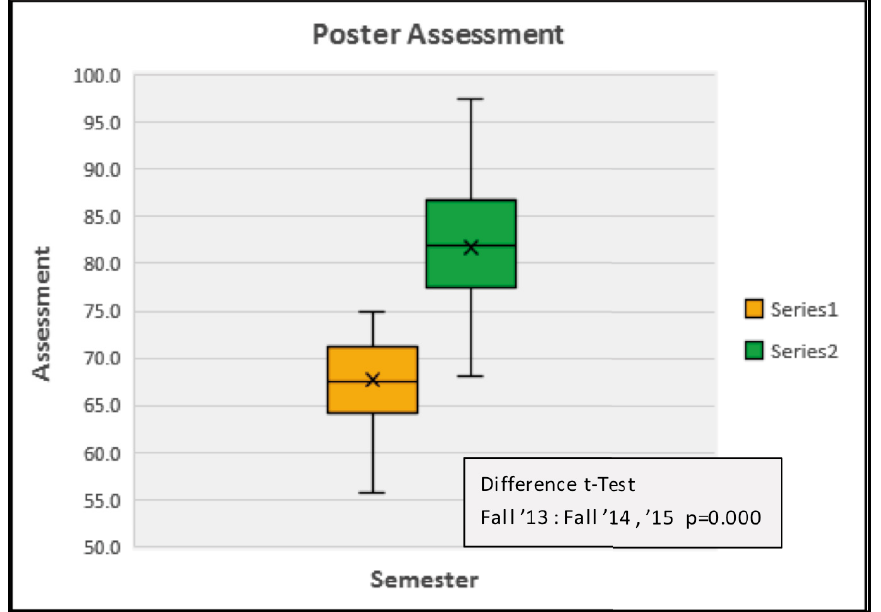
Fig. 7. Comparison of Technical Design Review Scores Before and After the Addition of an Earlier Feasibility